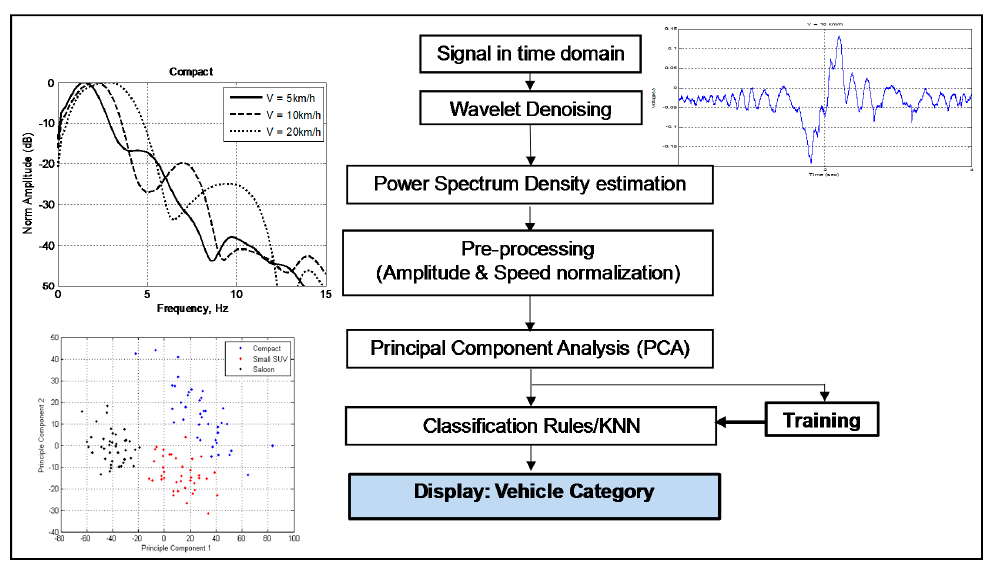
Figure 8. Classification system block diagram in passive FSR using LTE signal.